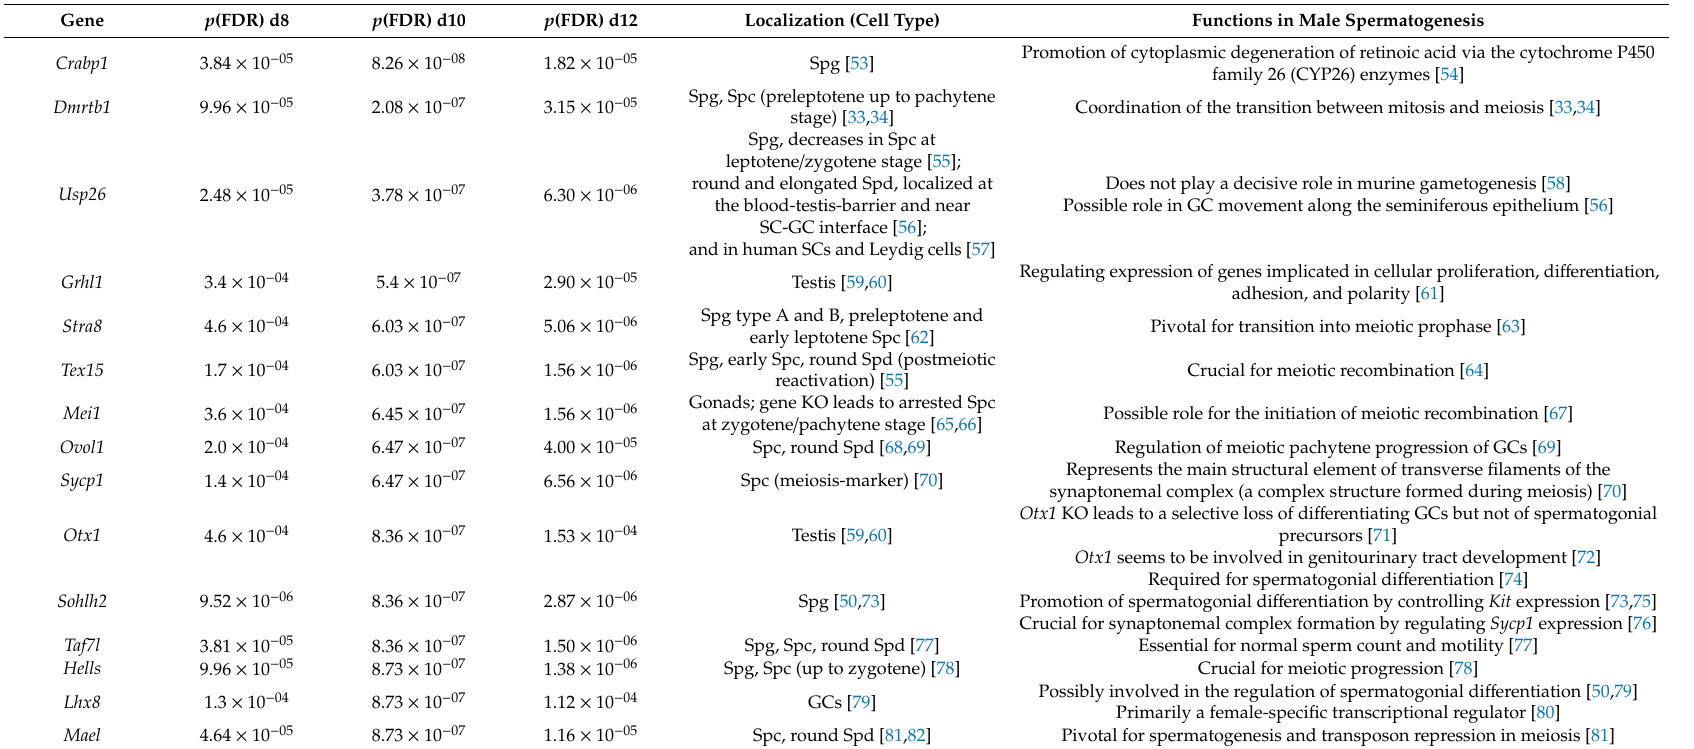
Table 6. List of di ff erentially expressed genes associated with